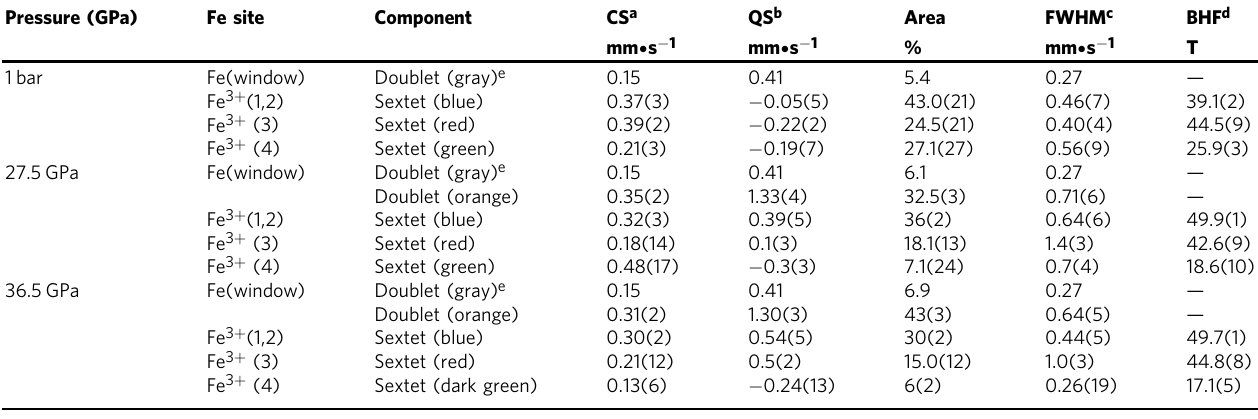
Table 3 Hyper fi ne parameters derived from room temperature SMS spectra of ε -Fe 2 O 3 . Uncertainties in the hyper fi ne parameters are indicated in brackets. Component column refers to the color in which each site is displayed in Fig. 5 Pressure